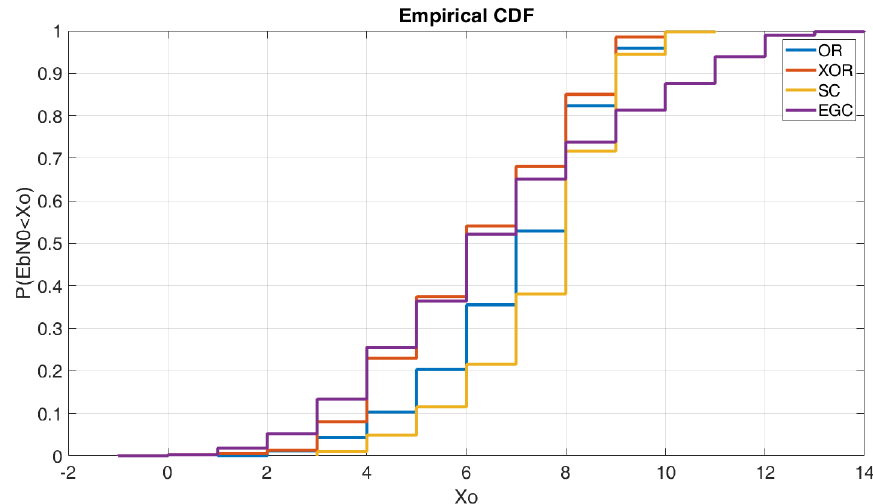
Figure 6. Bit energy to noise spectral density (E b / N 0 ) cumulative distribution function (CDF) of 4QAM at 50 W.